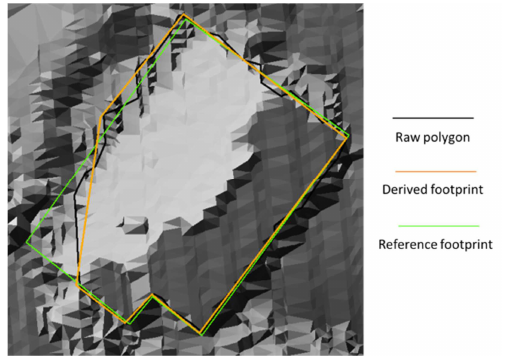
Figure 9. Difference between raw boundary and ground truth.